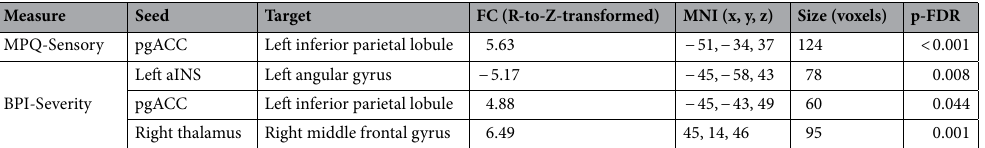
Table 2. Clusters of SCA connectivity exhibiting significant associations of treatment response with real M1-rTMS. FDR- and FWE-corrected p-values are also familywise-adjusted for the number of seeds in class. aINS anterior insula, pgACC pregenual anterior cingulate